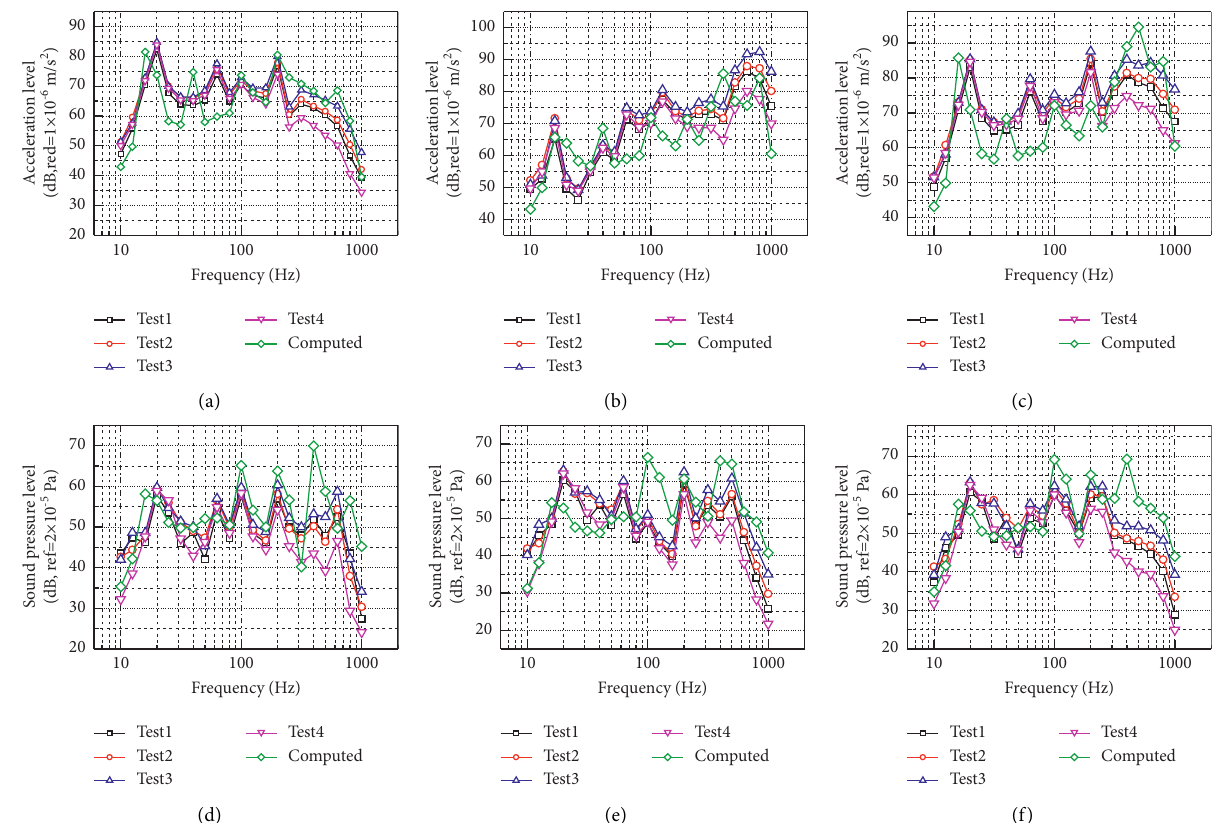
Figure 8: Comparison between the computed and test values of the acceleration and sound pressure at the measuring points. (a) A1. (b) A2. (c) A3. (d) S1. (e) S2. (f)